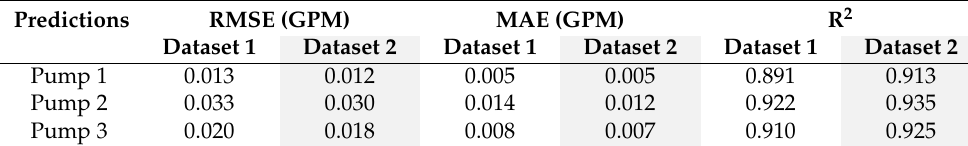
Table 6. Evaluation of the model trained with dataset 1 and dataset 2.